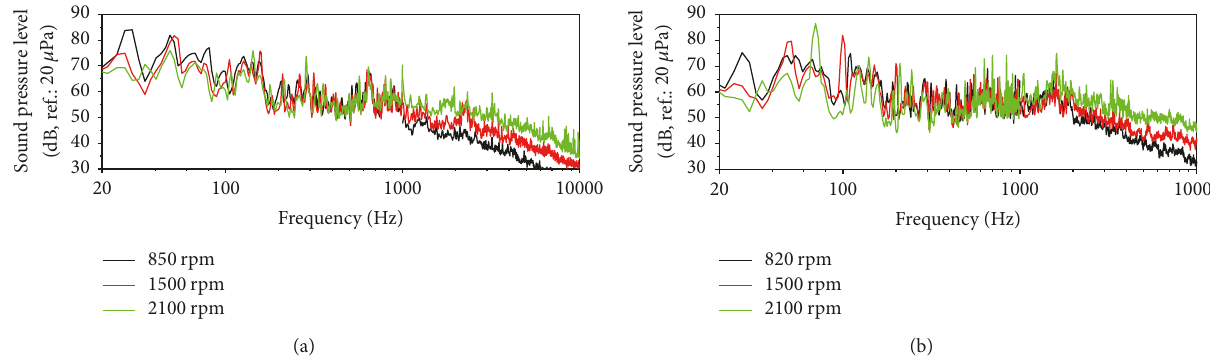
Figure 2: Spectral characteristics of (a) gasoline and (b) diesel engine sounds measured in the laboratory. The spectrum showed a decreasing level with increasing frequency, and the combustion noise at high frequencies over 1 kHz was larger for the diesel engine.